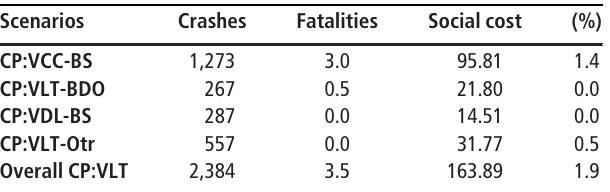
Table VII Crashes, fatalities and social cost of